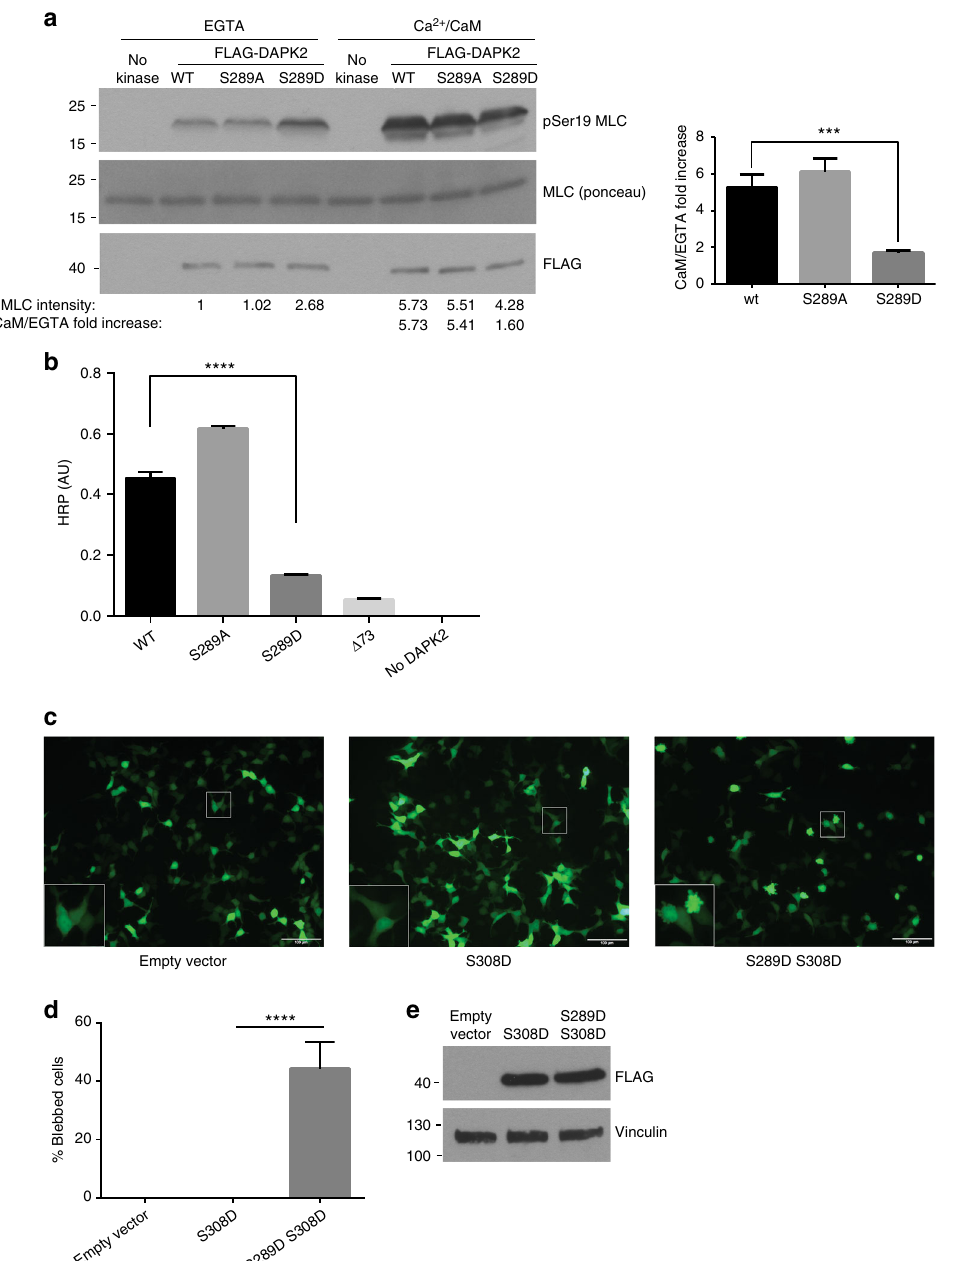
Fig. 4 Ser289 phosphorylation provides a CaM-independent mechanism of activation. a FLAG-DAPK2 WT, S289A or S289D was incubated in a kinase reaction mixture with MLC. Reactions were carried out with the addition of either EGTA or Ca 2 + /CaM. pMLC band intensity was quanti fi ed using NIH ImageJ software. The fold increase ratio upon addition of Ca 2 + /CaM was calculated by dividing the calculated intensity of the Ca 2 + /CaM lanes with the calculated intensity of the respective EGTA lanes. Bar graph represents CaM/EGTA fold increase as mean ± SD of three independent repeats. Statistical analyses were performed using one-way ANOVA with post hoc Dunnett ’ s multiple comparison test. *** P < 0.001. b ELISA plates were coated with CaM and incubated with DAPK2 WT or different mutants. Bar graph represents quanti fi cation of DAPK2 binding as mean ± SD of three technical repeats from one representative experiment out of three independent repeats. Statistical analyses were performed using one-way ANOVA with post hoc Dunnett ’ s multiple comparison test. **** P < 0.0001. c HEK293T cells were transfected with GFP and the indicated constructs and imaged 24 h post-transfection. Scale bar = 100 µ m. d Quanti fi cation of the extent of blebbing among GFP-positive cells. Bar graph represents percent of blebbed cells as mean ± SD of three biological repeats. Statistical analyses were performed using one-way ANOVA with post hoc Dunnett ’ s multiple comparison test. **** P < 0.0001. e Western blot of a representative experiment from